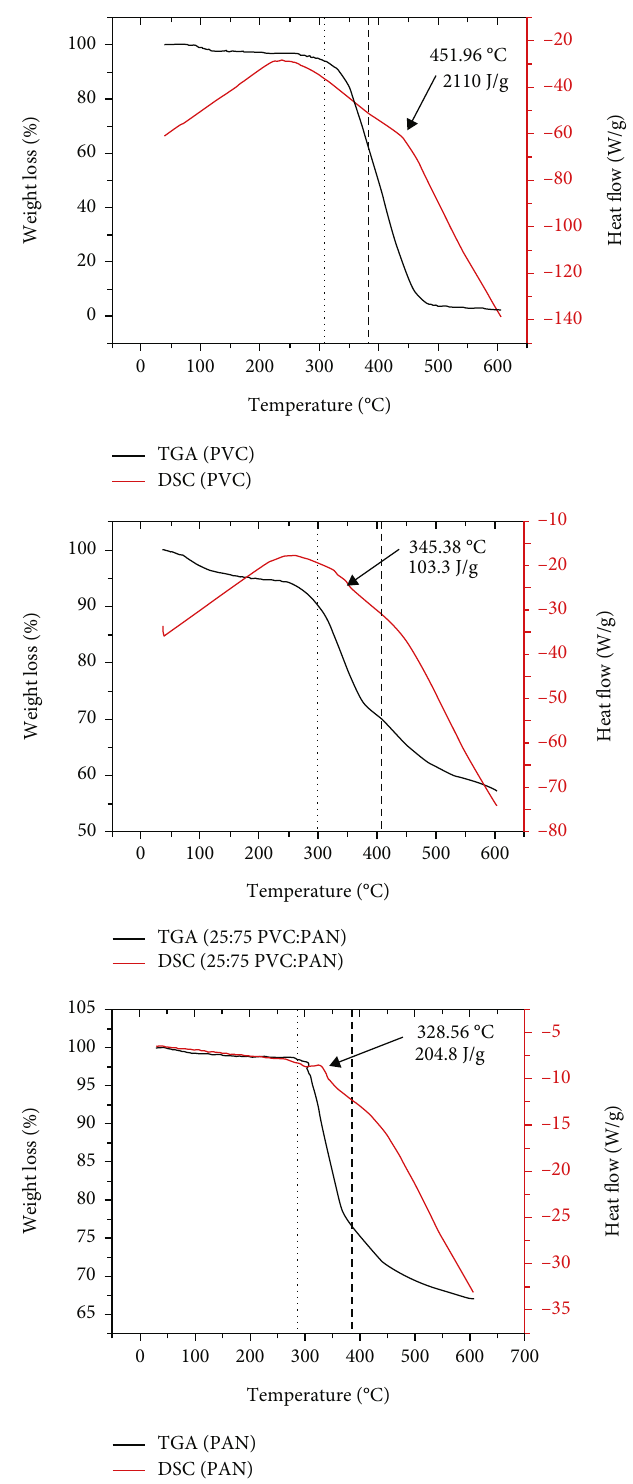
Figure 8: TGA-DSC analysis curves for pure PAN, pure PVC, and 25: 75 PVC: PAN nano fi